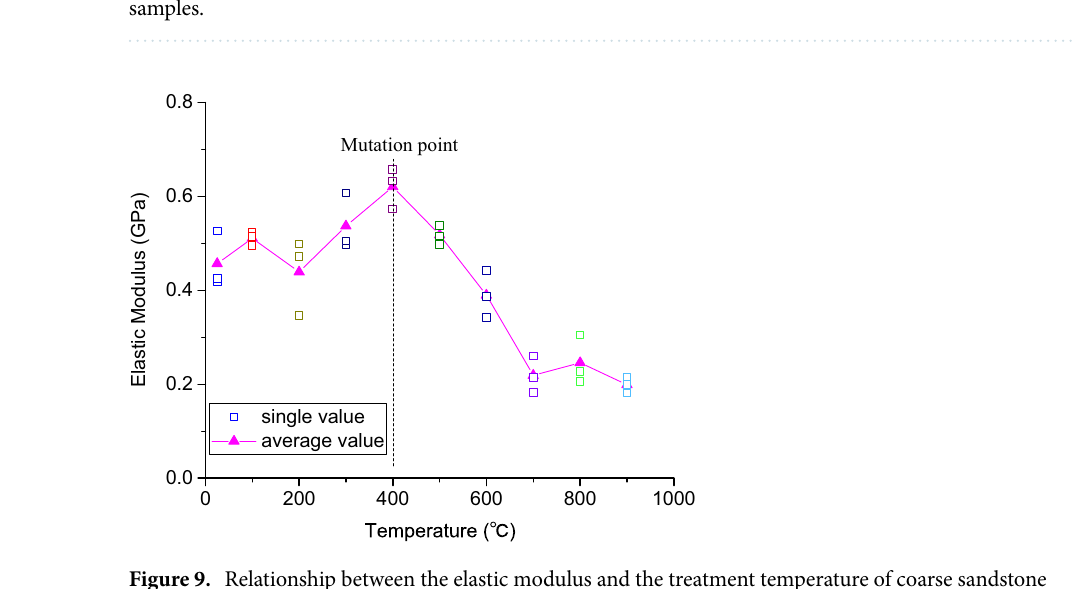
coarse sandstone, and its variation characteristics were consistent with the tensile strength variation trend of the samples.